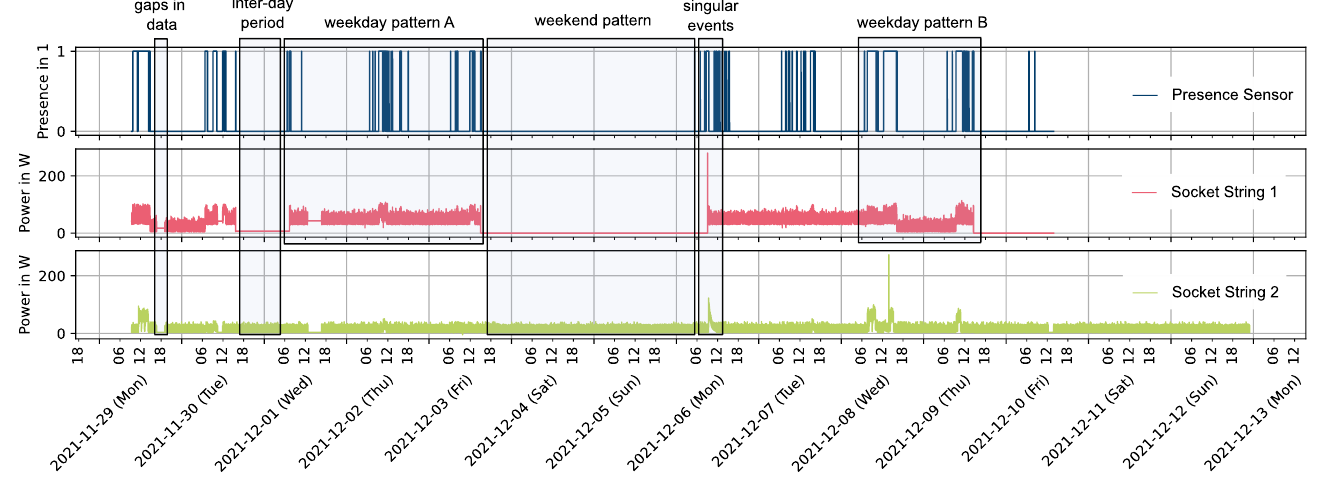
Figure 12. Data obtained through the advanced sensor and control network, including presence detection (top) and electric power measurements on two socket strings (center and bottom) for one office located in the JSL. Important observations are